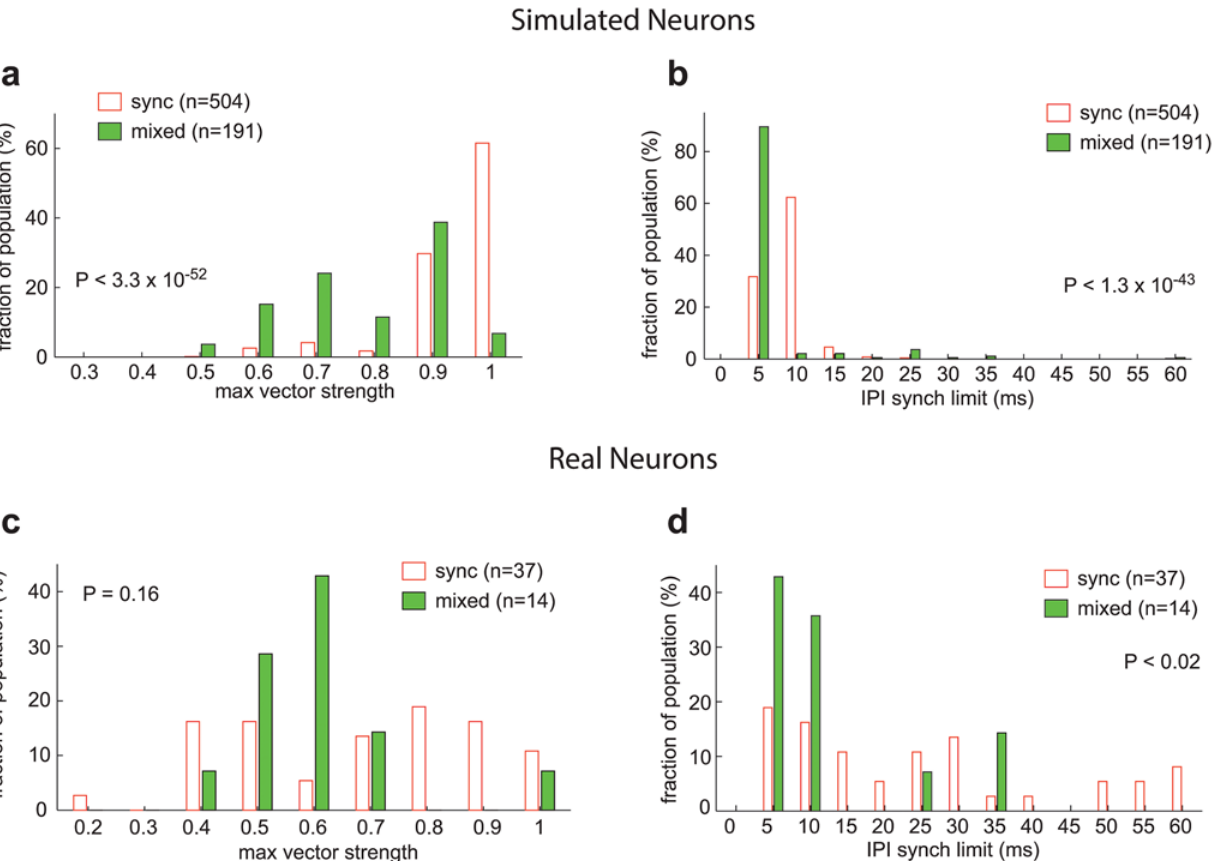
Fig 8. Temporal fidelity of synchronized and mixed neurons. Only simulated neurons with an excitatory input strength between 3 – 6 nS were used in this analysis, such that synchronized and mixed neurons had a similar distribution of excitatory levels. a. Max vector strength distribution for acoustic pulse train responses in simulated neurons. Mean: sync = 0.93, mixed = 0.79, Wilcoxon rank sum test: P < 3.3 x 10 -52 . b. IPI synchronization limit distribution for acoustic pulse train responses in simulated neurons. Mean: sync = 10.2 ms, mixed = 7.7 ms, Wilcoxon rank sum test: P < 1.3 x 10 -43 . c. Max vector strength distribution for acoustic pulse train responses in real neurons. Mean: sync = 0.68, mixed = 0.60, Wilcoxon rank sum test: P = 0.16. d. IPI synchronization limit distribution for acoustic pulse train responses in real neurons. Mean: sync = 25.7 ms, mixed = 13.4 ms, Wilcoxon rank sum test: P < 0.02.